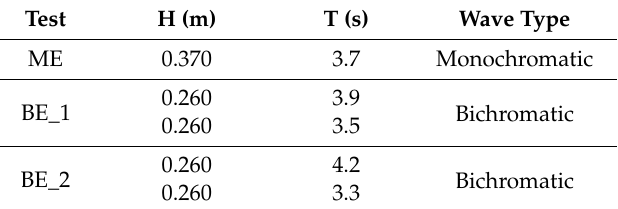
Table 2. Wave characteristics for erosive